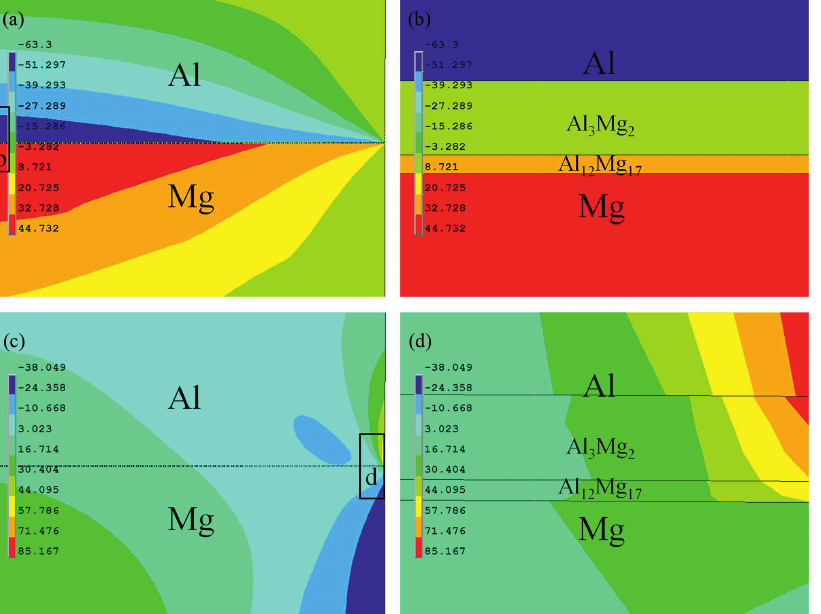
Figure 5: Distribution of stress calculated